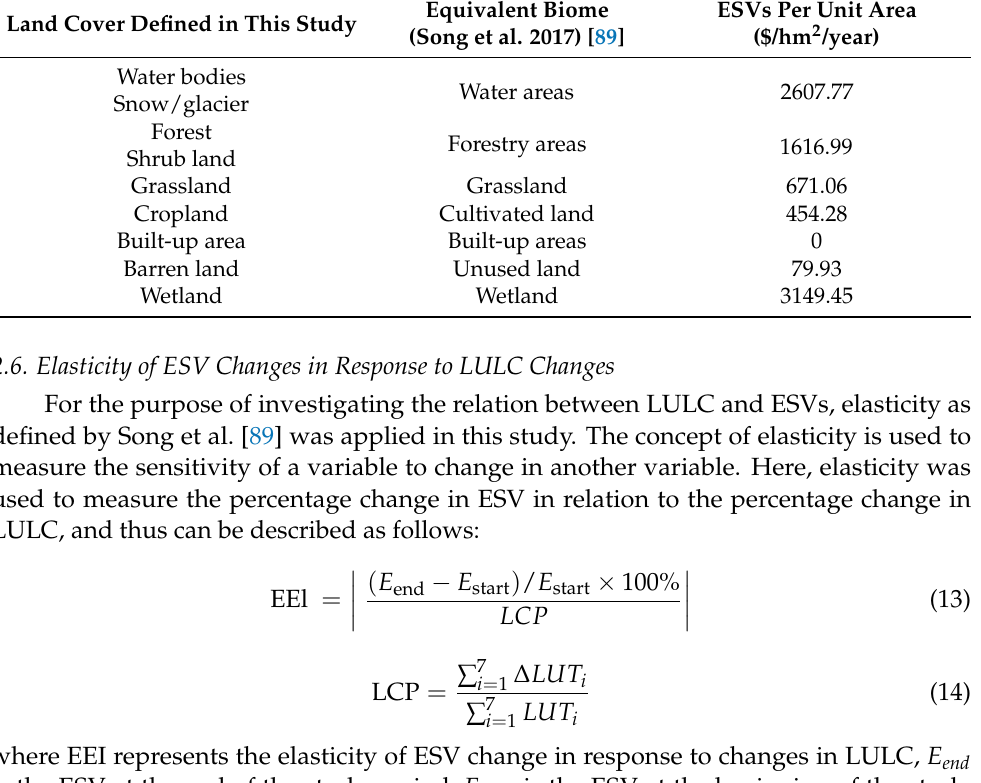
Table 2. Ecosystem service values (ESVs) of land cover types defined in this study. Land Cover Defined in This